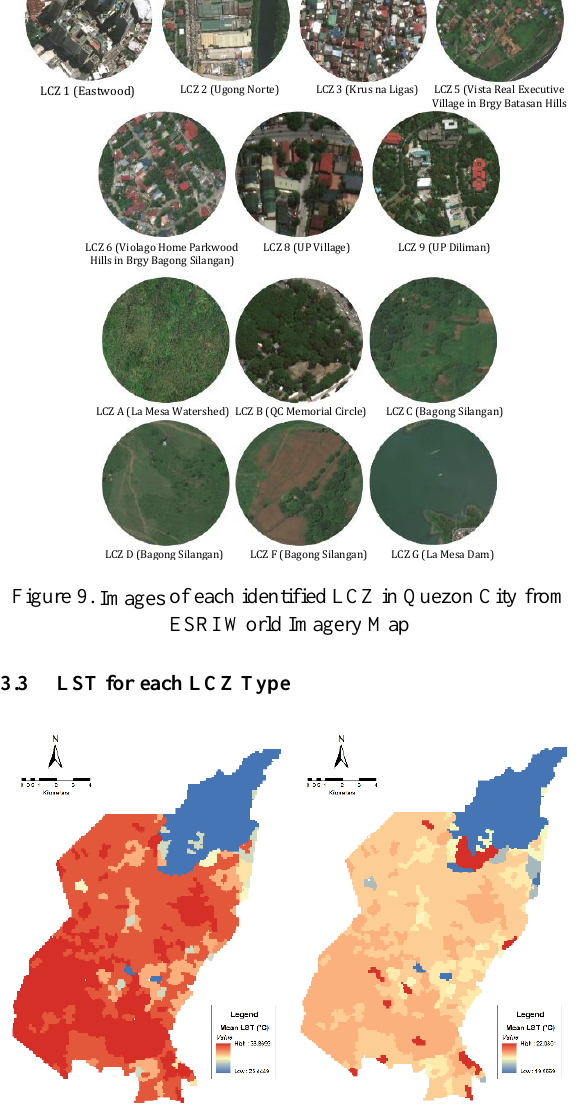
Figure 10. Mean daytime (left) and night-time (right) LST per Local Climate Zone in Quezon City,